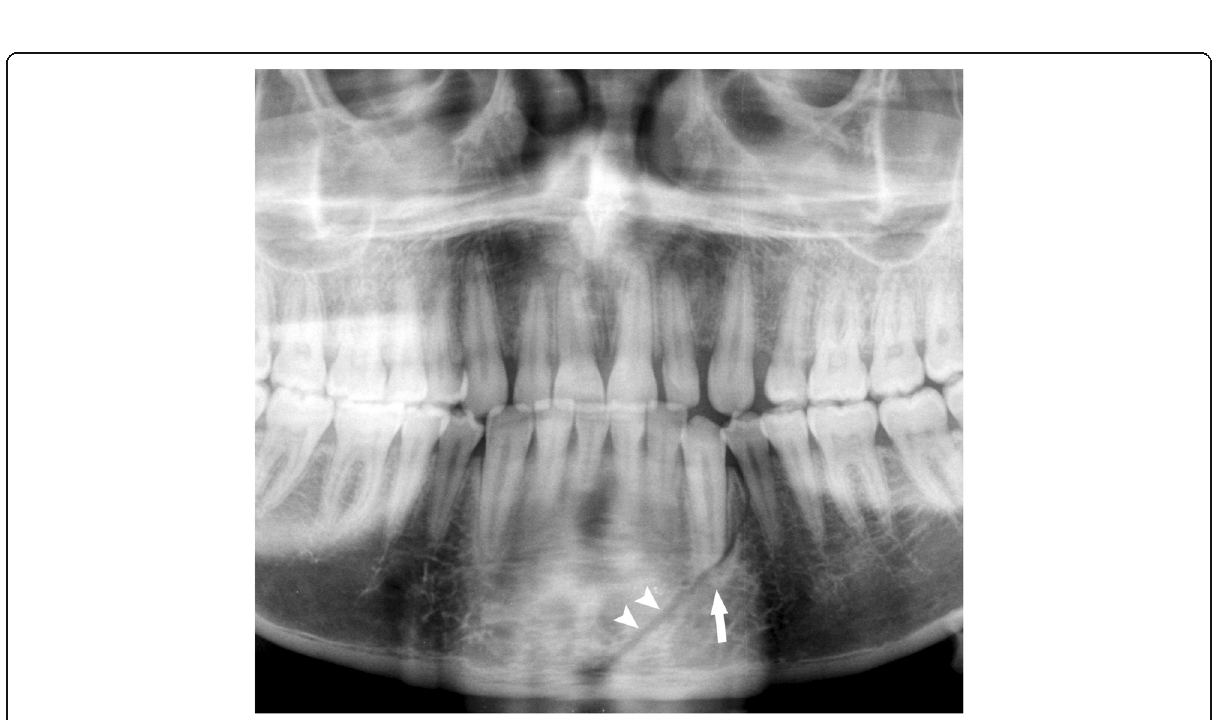
Fig. 2 Symphysis fracture. Cropped panoramic radiograph. The fracture rhyme (arrowheads) runs from the base of the mandibular symphysis to the alveolar process of the lower left first premolar. The root apex of the canine is fractured